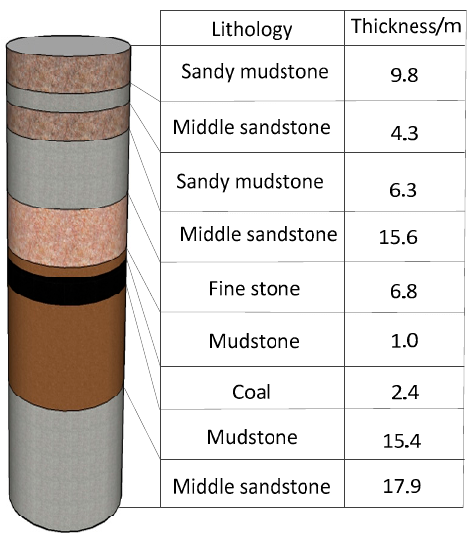
Figure 2. The lithologic information of the 72207 working face.